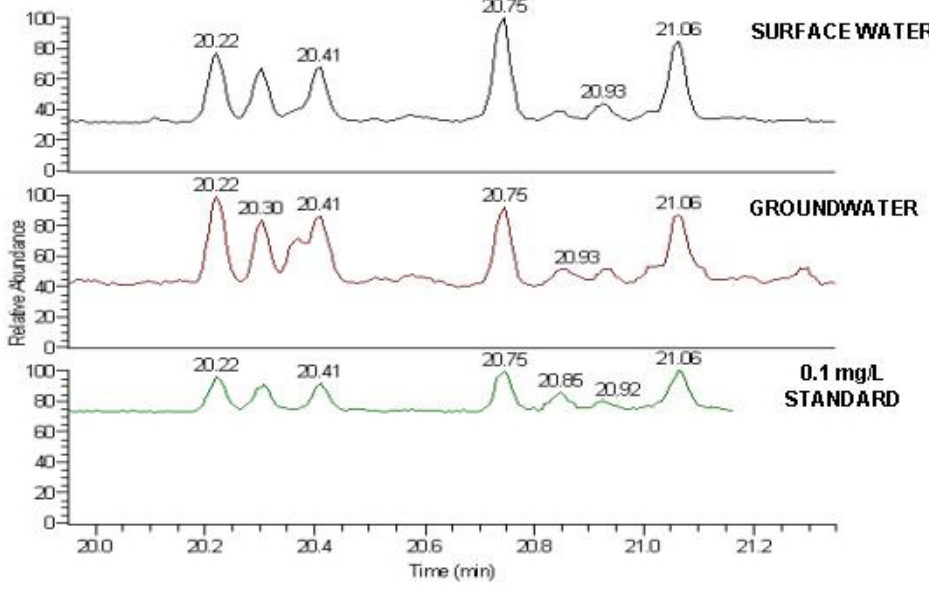
FIGURE 2. GC-EI-MS chromatogram of NP, OP, and BPA in surface water, groundwater, and a